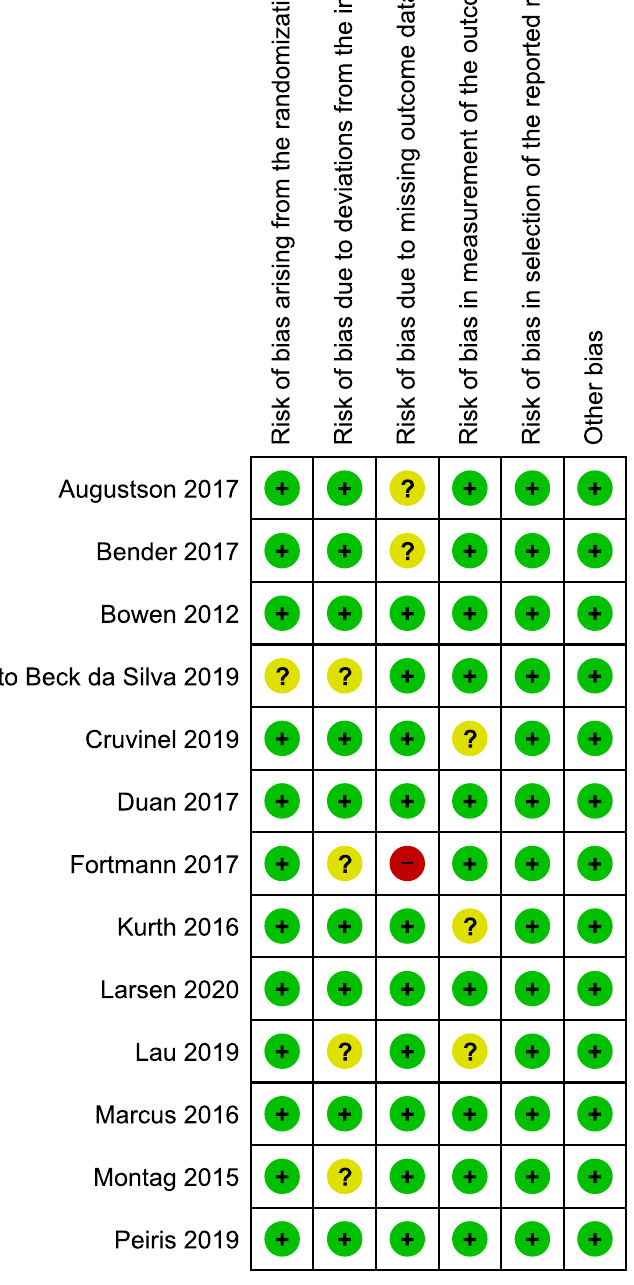
Fig. 2 Risk of bias graph. Reviewers' judgments about each risk of bias item presented as percentages across all included